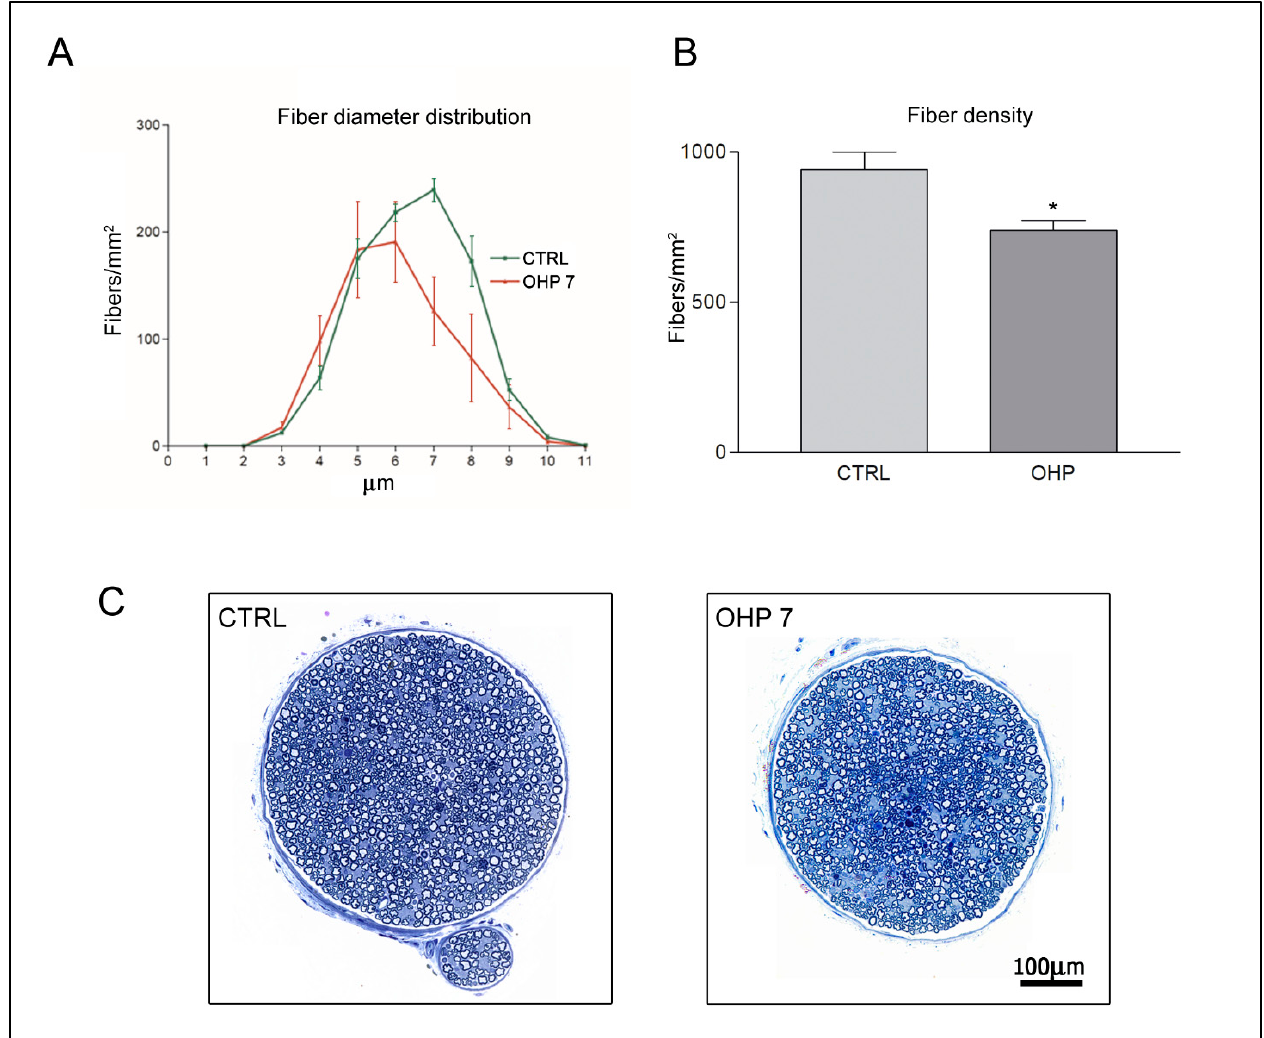
Figure 4. Morphological and morphometrical assessment of caudal nerves at the end of treatment. ( A ) shows the graph of the distribution of fiber diameters (SEM bars are represented). ( B ) shows the box-plot graph (standard deviation bar is shown) of statistical analysis ( t -test) of morphometry. In ( C )) representative images of CTRL and OHP animals are shown, to highlight the mild axonal loss in caudal nerves of the OHP group: fiber density is moderately diminished and degenerating fibers are visible in OHP group. CTRL: control group; OHP7: OHP-treated group. * p -value < 0.05 vs. CTRL.